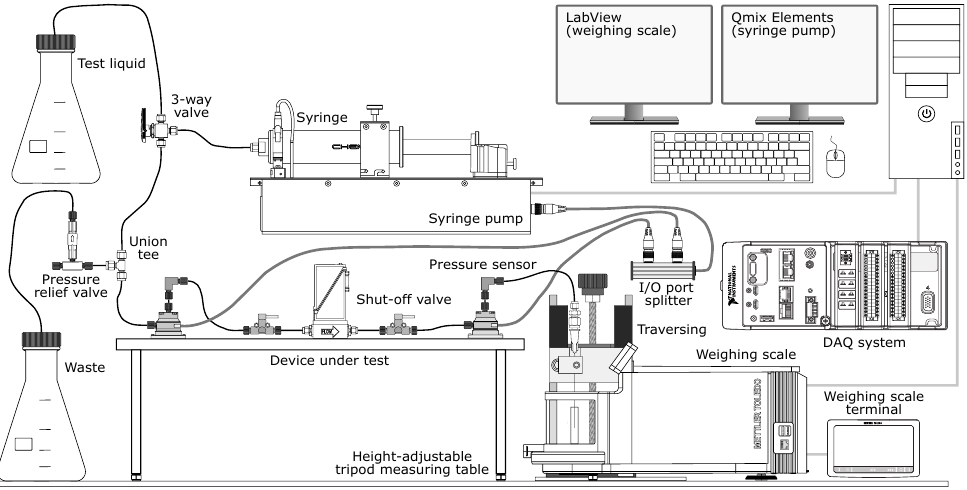
Figure 1. Schematic illustration of a typical measurement setup (Nanoflow test facility) for the cali- bration of a flow meter as DUT.